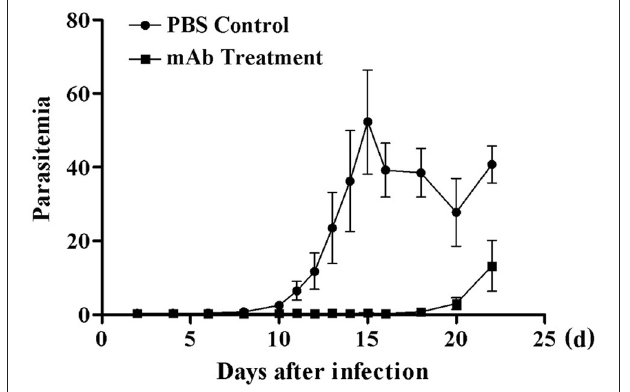
FIGURE 7 | Parasitemia in NOD/SCID mice receiving anti-BMSA monoclonal antibody therapy. NOD/SCID mice were administered a total 5mg of monoclonal antibody on days − 1, 0, and + 1 and were challenged with 1 × 10 5 erythrocytes infected with B. microti on day 0. Parasitemia was measured every second day using flow cytometry after staining with SYBR Green I (1.00,000 events). The data represent two individual